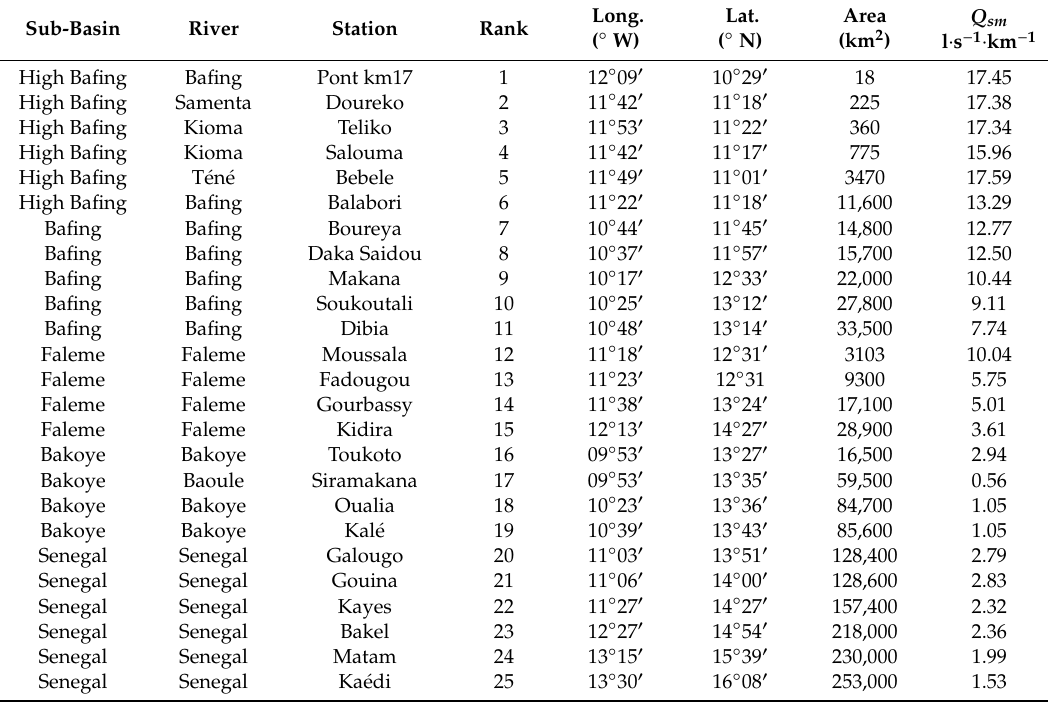
Table 1. Senegal basin-list of stations analyzed, with their catchment area and mean specific discharge Q sm over the period